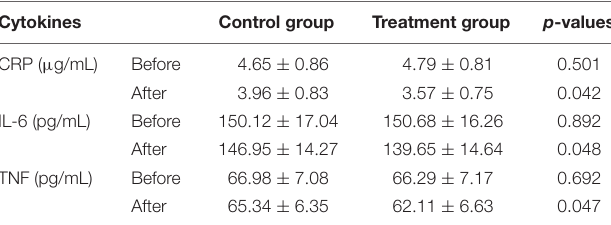
The statistical difference was significant if p < 0.05 vs. the control group.